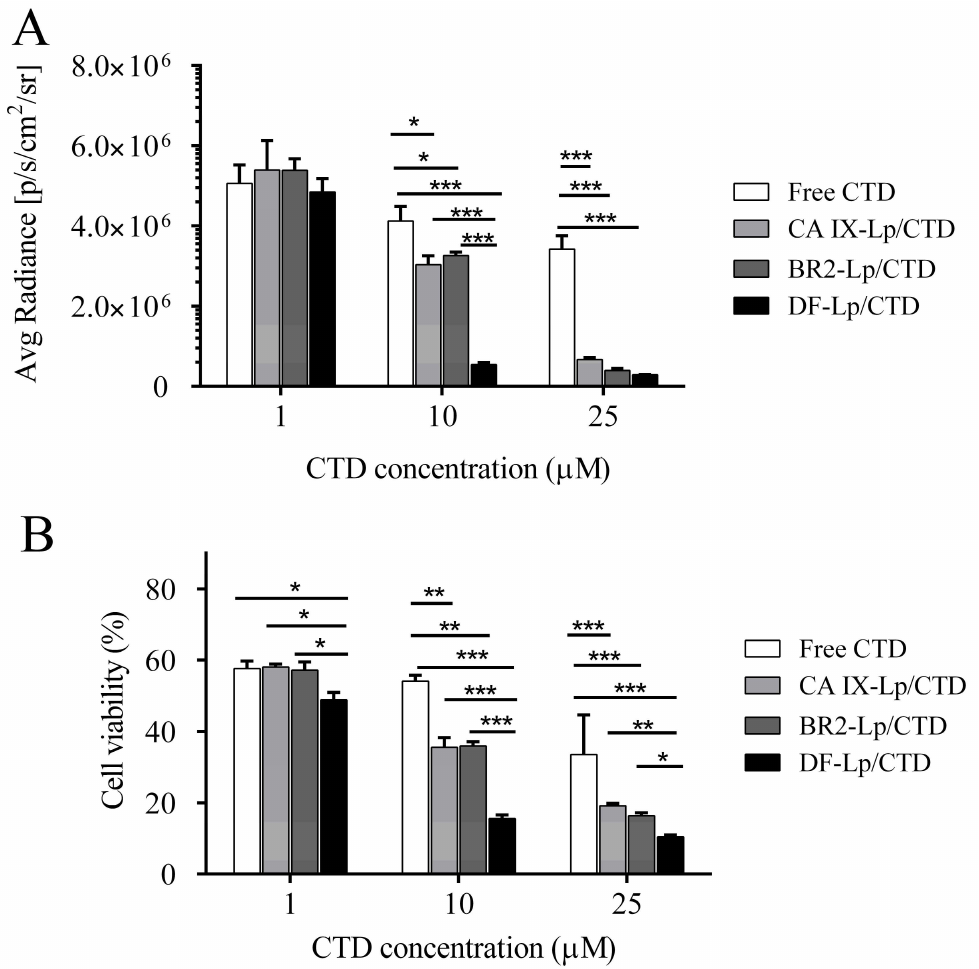
Figure 5. Cell viability assay of di ff erent liposomal formulations. HepG2-red-Fluc cells grown in black or transparent 96-well plate were treated with di ff erent CTD-liposomal formulations with CTD concentration at 1 µ M, 10 µ M, and 25 µ M for 24 h. Then the bioluminescent intensity were tested by IVIS imaging systems ( A ) and the relative cell inhibitory e ff ects were determined by MTT assay ( B ), respectively. * p < 0.05, ** p < 0.01, *** p <